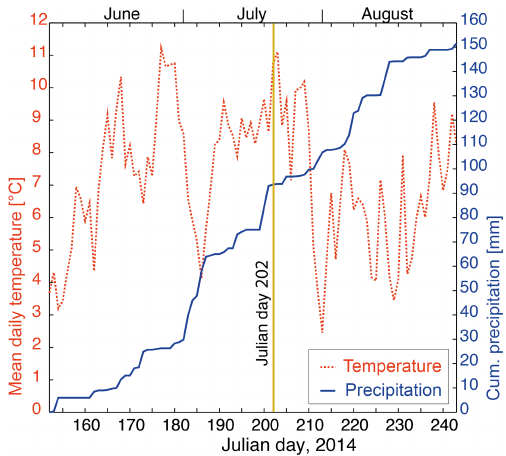
Figure 2. Mean daily temperatures and cumulative precipitation at weather station Kárahnjúkar (see Fig. 1 for location) in June, July, and August 2014. Note the 2 days with high precipitation immedi- ately before and the increased temperature on the day of the land- slide (Julian day 202, yellow line).